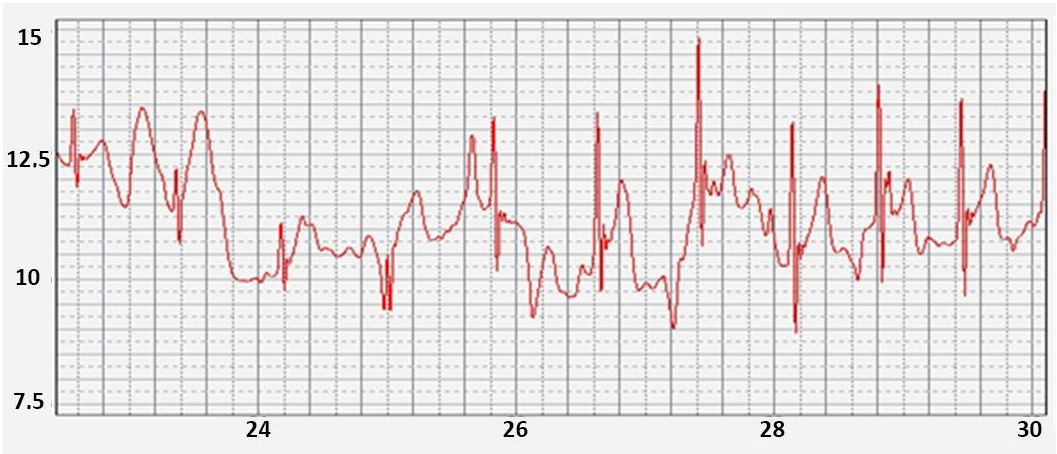
Figure 4. ECG from chest non-standard ECG leads recorded through clothing.